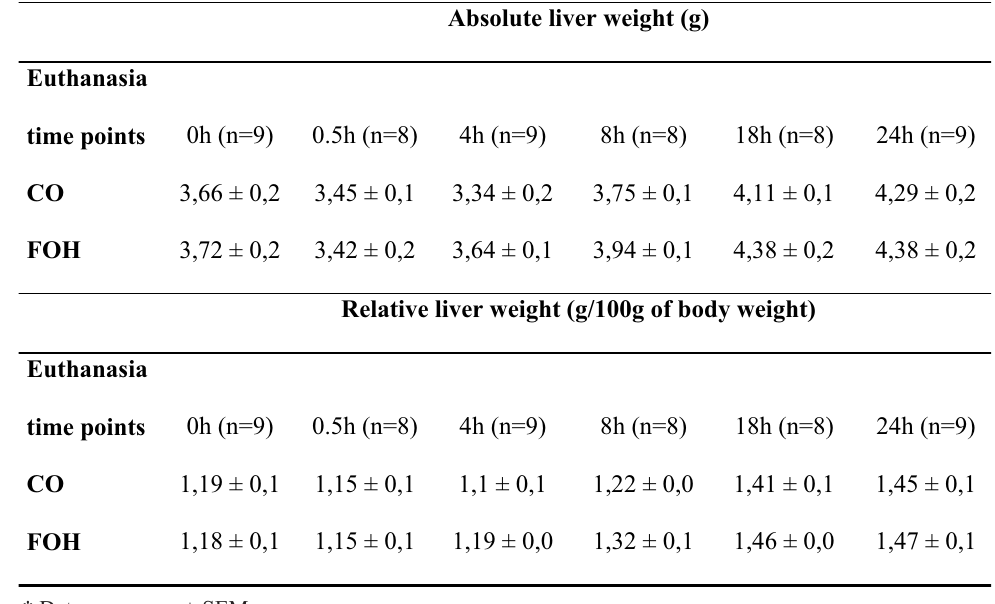
TABLE 1 - Absolute and relative liver weight of rats treated for two consecutive weeks with CO or FOH and submitted to